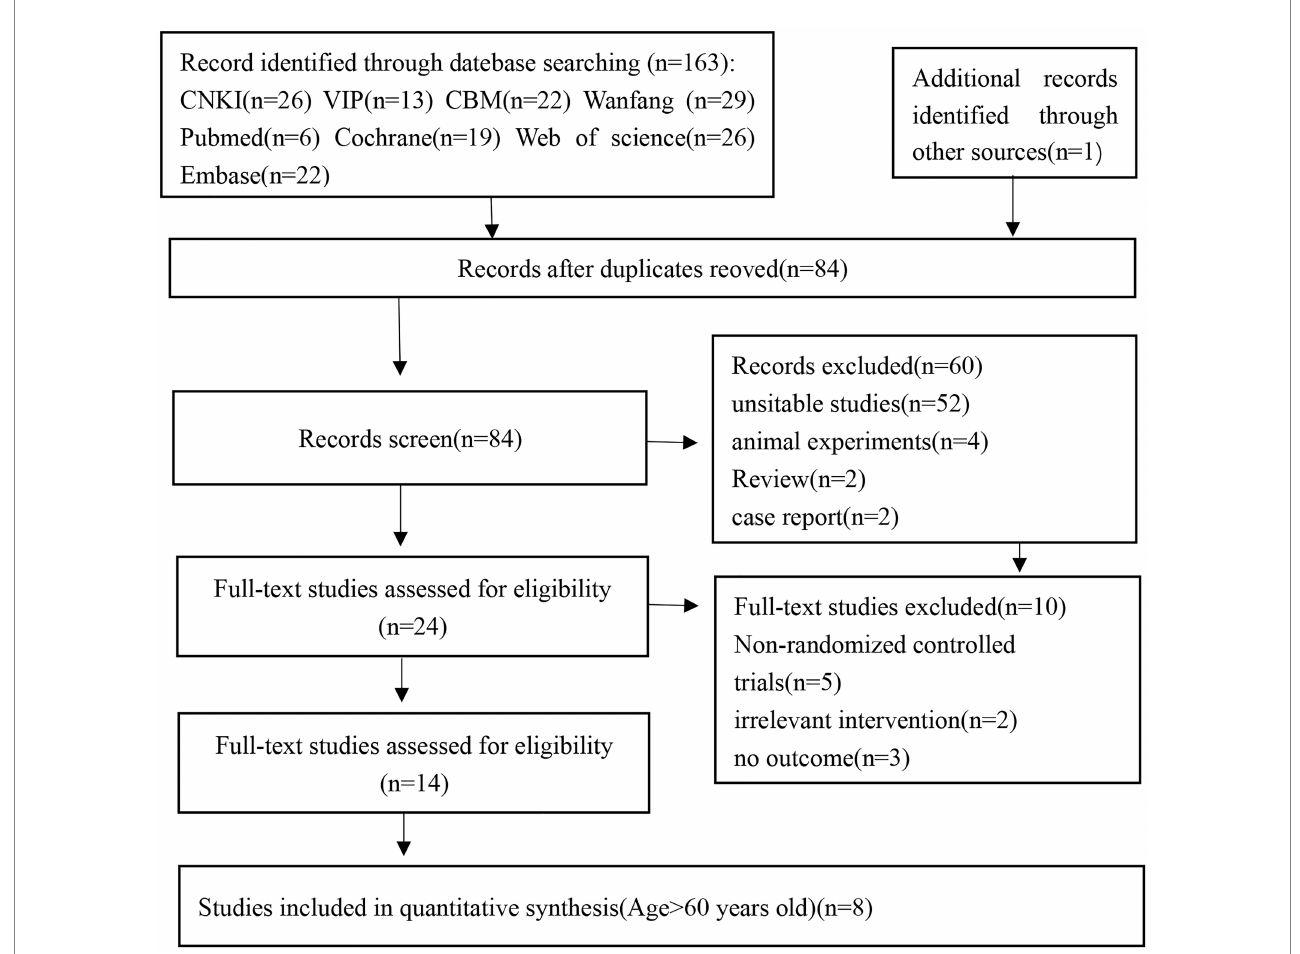
FIGURE 1 Flow diagram of the literature